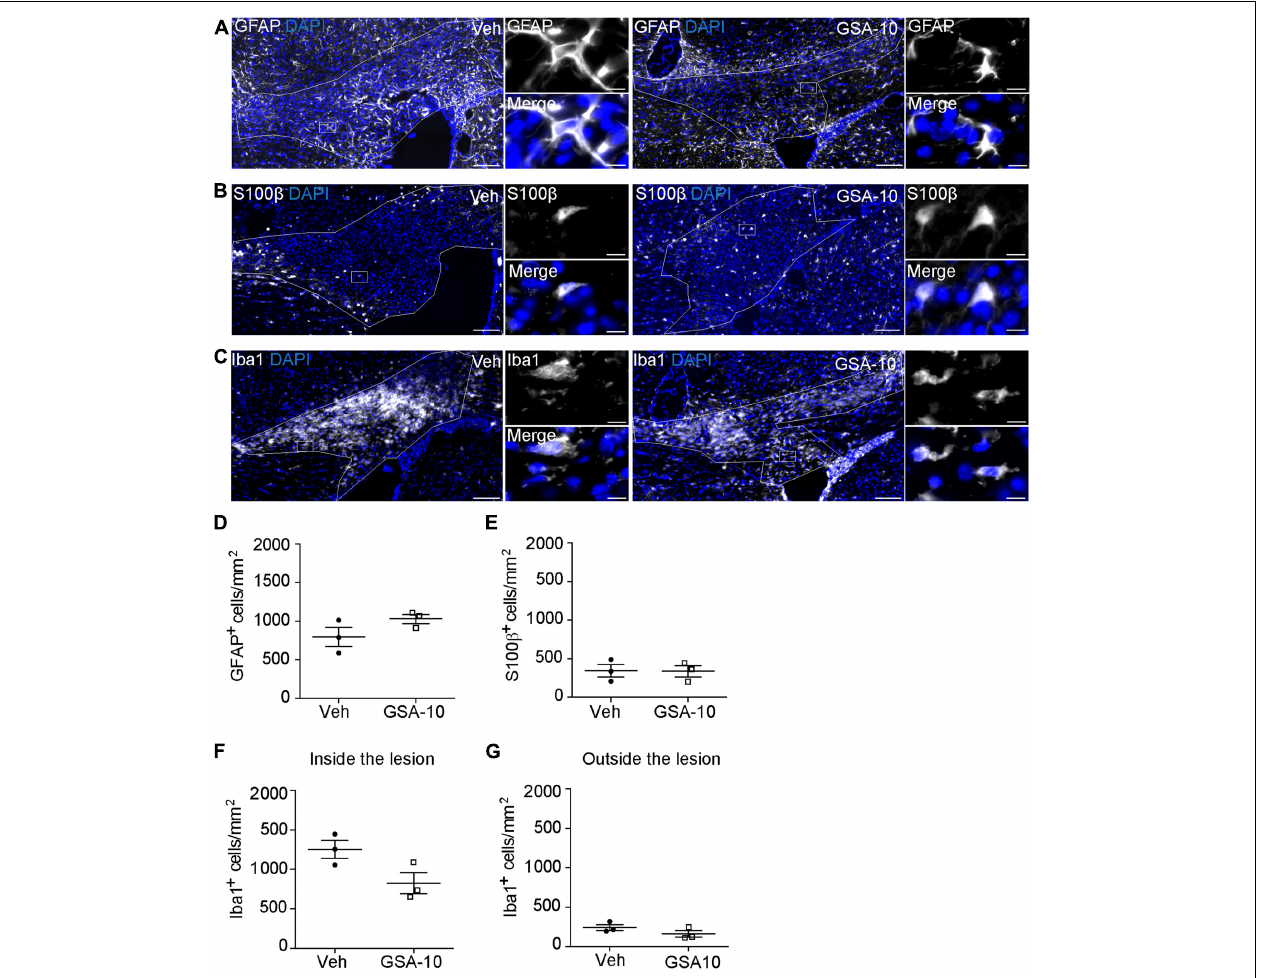
FIGURE 7 | GSA-10 does not affect astrogliosis and microgliosis in the lesioned corpus callosum. (A–G) Distribution of (A) GFAP and (B) S100 β astroglial markers or (C) Iba1 microglial marker inside the lesioned corpus callosum of vehicle (Veh) and GSA-10 treated mouse brains. GSA-10 does not modify significantly the density of (D) GFAP + , (E) S100 β + , or (F) Iba1 + cells inside the lesion. Most S100 β + cells display a cytoplasmic labeling characteristic of astroglial cells. Moreover, as observed inside the lesion, the number of Iba1 + microglia cells was not modified by GSA-10 outside the lesion (G) . Mean ± SEM, n = 3–4 experimental replicates. White squares are magnified on the right side of the main panel, showing positive cells in merge and single channel with the nuclear marker DAPI (blue). Scale bar: (A–C) = 100 µ m; all magnifications = 10 µ